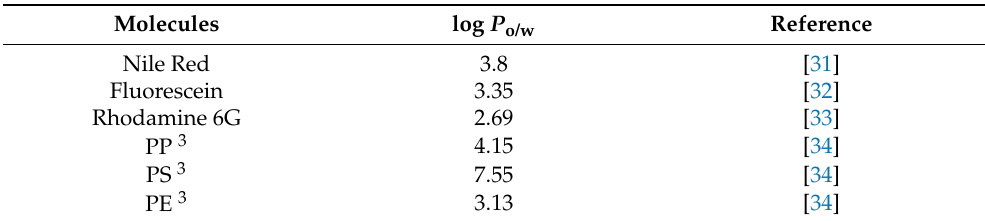
Table 2. The values of partition coefficient, log P o/w , for three microplastics and three fluorescent dyes. Molecules log P